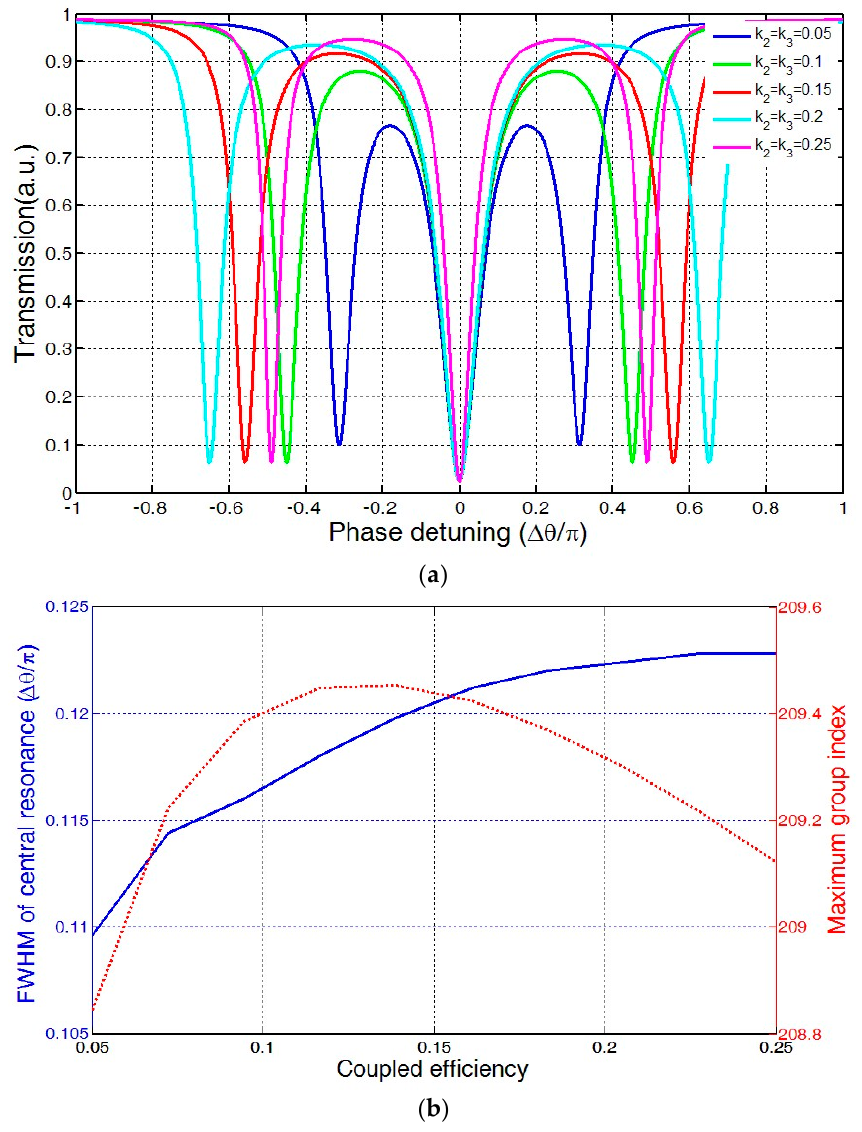
Figure 3. Effect of ring-ring coupling coefficient: ( a ) on transmission spectrum ( b ) on FWHM of central resonance and maximum group index.